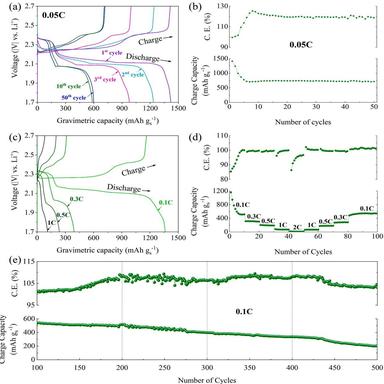
Charge-Discharge performance of the S-SiOC composite as the cathode of Li–S cells. (a) Voltage profile of the 1st, 2nd, 3rd, 10th, and 50th cycles at 0.05 C, (b) Cycling stability data for 50 cycles at 0.05 C. (c) Voltage profile of the initial cycles at 0.1 C, 0.3 C, 0.5 C, and 1 C. (d) Charge capacity values for 0.1 C, 0.3 C, 0.5 C, 1 C, and 2 C. (e) Cyclability test, which consisted of conducting 400 cycles at 0.1 C after the C-rate test. Electrolyte: 1 M LiTFSI in DOL/DME (v/v, 1:1) containing 1 wt % of